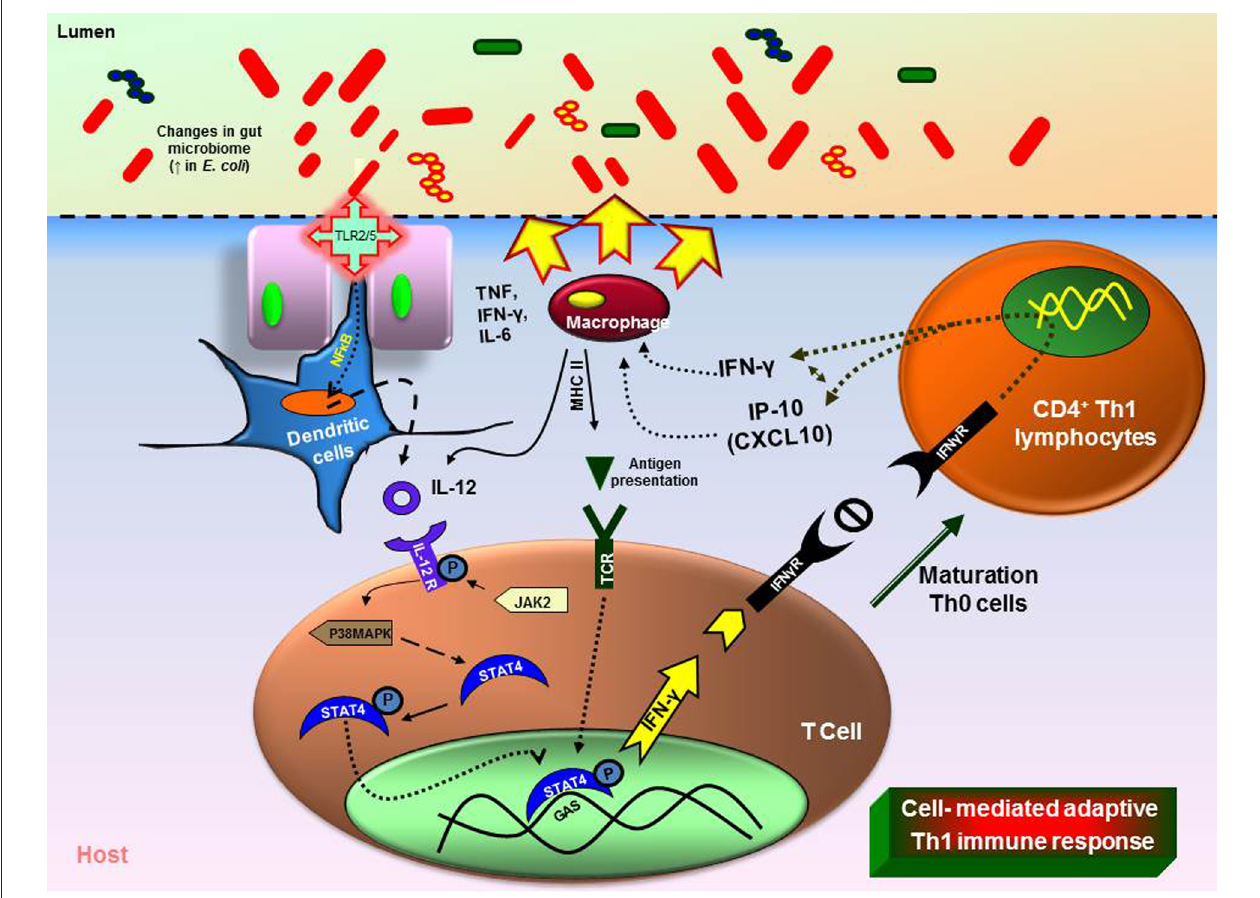
FIGURE 1 | Immune responses triggered by changes in the gut microbiome. Intestinal inflammation in the UC or CD leads to dysbiosis (imbalance microbiota). Overgrowth of enteropathogenic bacteria causing increased activation of toll-like receptors (TLR) 2 or 4. This causes the activation and translocation of nuclear factor kappa B (NF κ B) and causes secretion of pro-inflammatory cytokine interleukin (IL)-12. Increased IL-12 causes T-helper (Th) Th1/Th2 immune response with increase in tumor necrosis factor (TNF), IL-6, interferon gamma (IFN- γ ). The dysbiosis leads to increase in immune cells (macrophages, neutrophils) at the infected site causing severe inflammation (MHCII—major histocompatibility